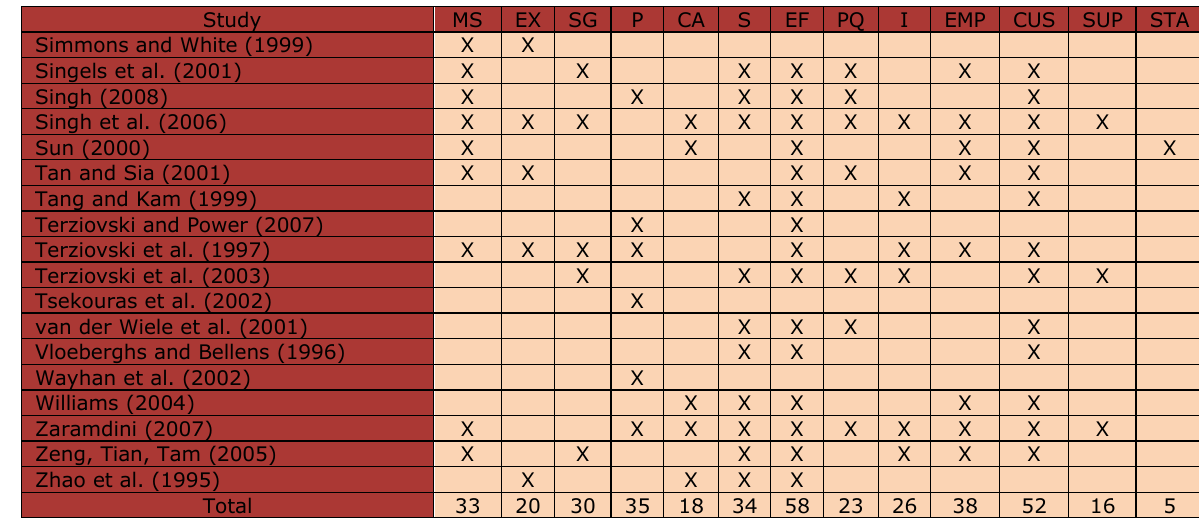
Table 1. Benefits of the ISO 9001